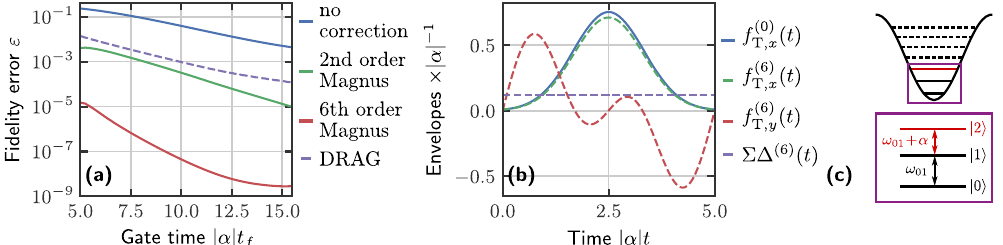
Fig. 4 Fast and high- fi delity single-qubit gates with a transmon. a Average fi delity error for a Hadamard gate as a function of the gate time. The blue trace is calculated using the uncorrected Hamiltonian (see Eq. (69)). The green trace is obtained for the 2nd order corrected Hamiltonian. The red trace is obtained for the 6th order corrected Hamiltonian. The purple dashed line is obtained using the DRAG correction. b Initial envelope functions (solid lines) and 6th order corrected envelope functions (dashed lines) for α j j t f ¼ 5 (see Eq. (76)). c Schematic energy level diagram of a